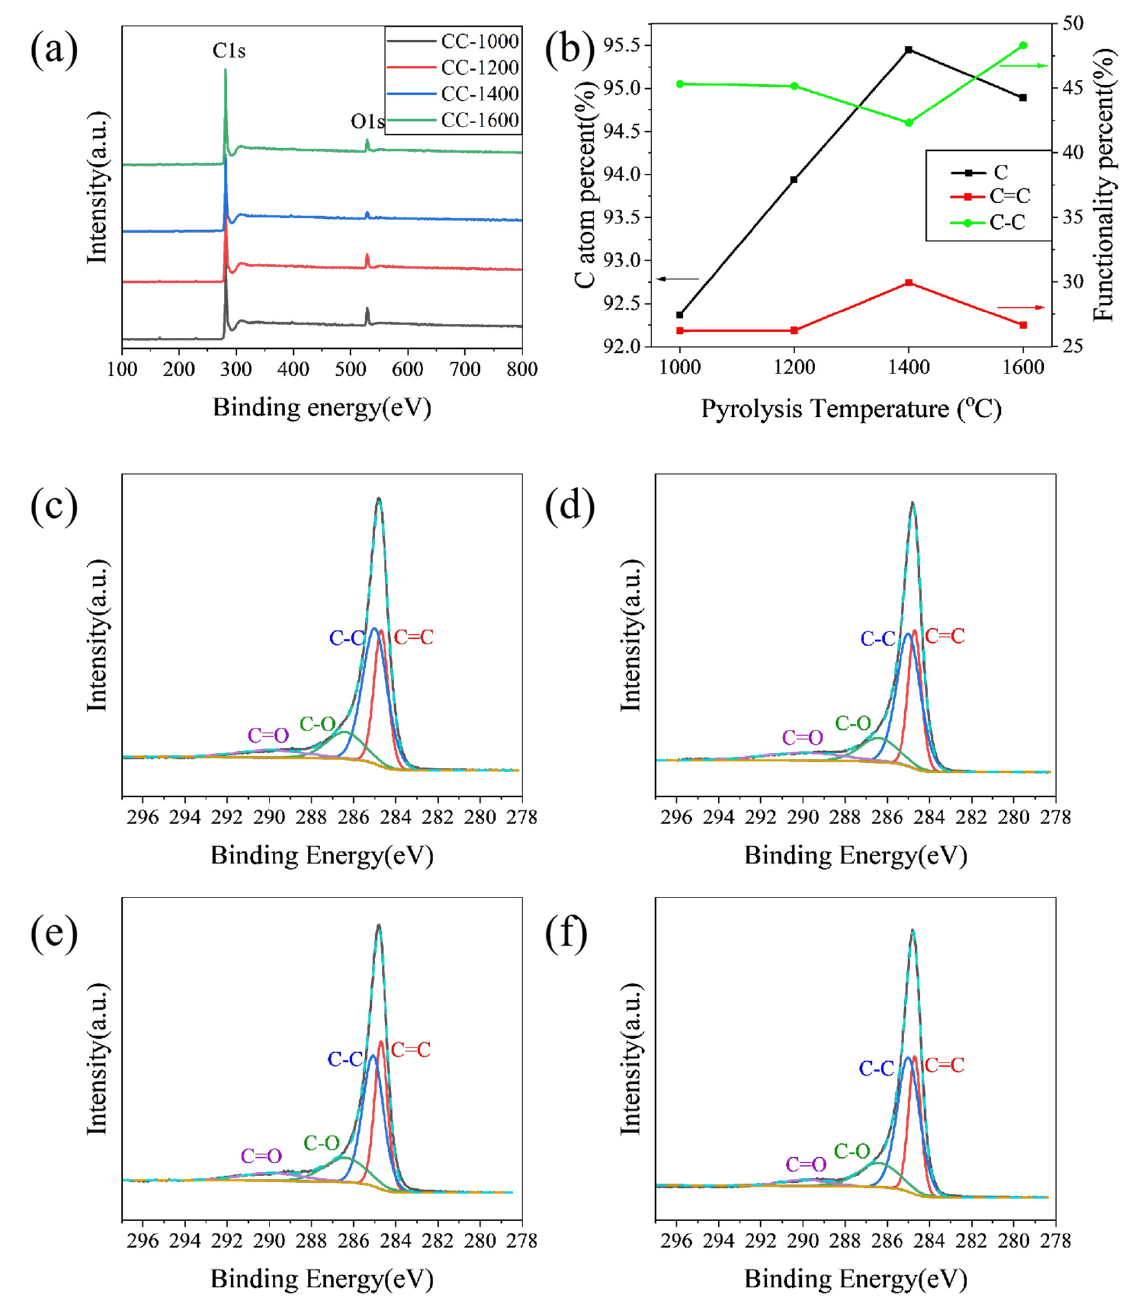
Figure 2. ( a ) XPS wide spectra; ( b ) functionality percent and C atom percent; high-resolution of C1s Table 1. Physical parameters calculated by XRD and Raman patterns of the as-obtained